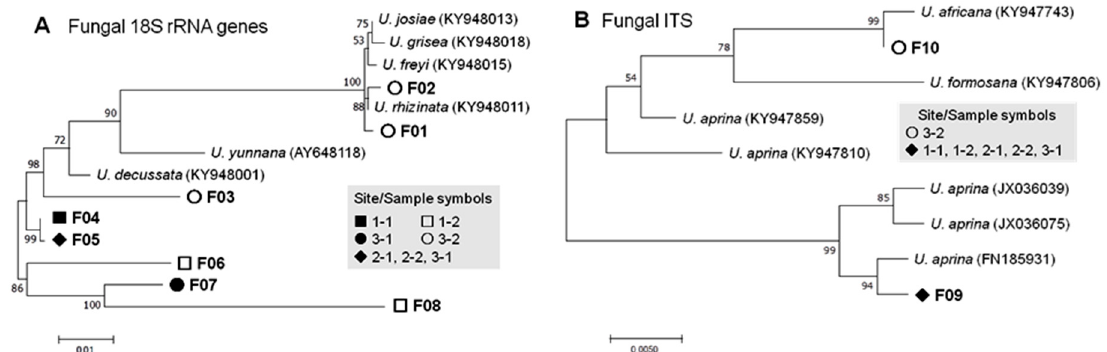
Figure 3. Phylogenetic trees of 18S rRNA genes ( A ) and ITS regions ( B ) of the lichen-forming fungal phylotypes and related Umbilicaria species (with accession numbers) generated by the Maximum Composite Likelihood method. The tree with the highest log likelihoods ( − 3645.00 and − 896.60 for A and B, respectively) is shown. The percentage of trees in which the associated taxa clustered together is shown next to the branches. The tree is drawn to scale, with branch lengths measured in the number of substitutions per site. Phylotype codes correspond to those shown in Table 4.